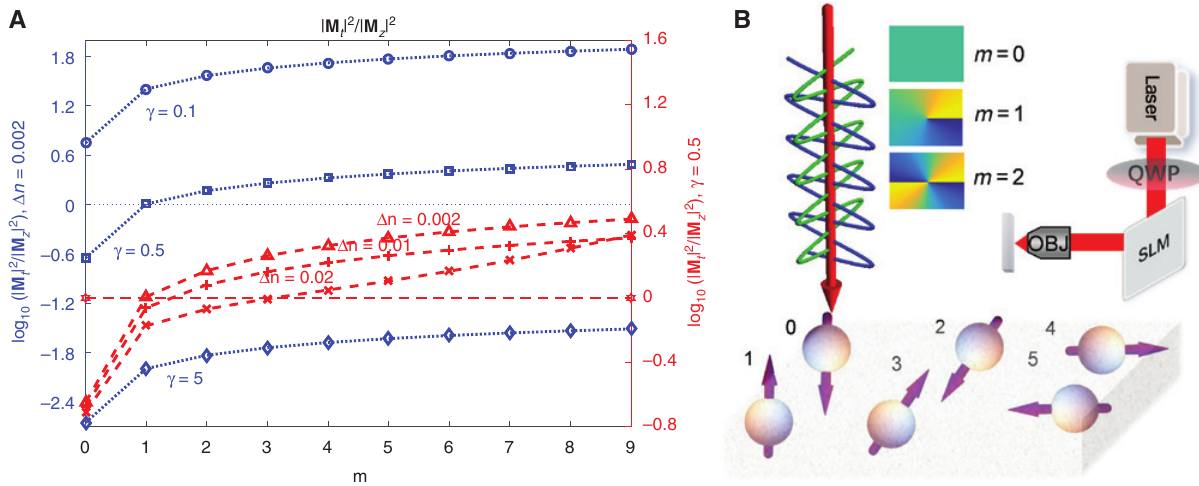
Figure 6: Illustration of the idea of all-optical multistate magnetization, and schematic of its realization. (Color online) (A) Optically induced magnetic energy density as a function of m for configurations of three different γ values, γ = 0.1, 0.5, and 5, and three different Δ n values, Δ n = 0.002, 0.01, and 0.02. (B) Scheme for the generation of all-optical multistate magnetization using circularly polarized vortex light. The top right corner shows the schematic of the optical setup system. The linearly polarized light emitted from the laser is converted into the circularly polarized one by the quarter wave plate (QWP). The SLM encodes phase into the light with m = 0, m = 1, or m = 2. Then, the light is focused by the objective (OBJ) into the uniaxial